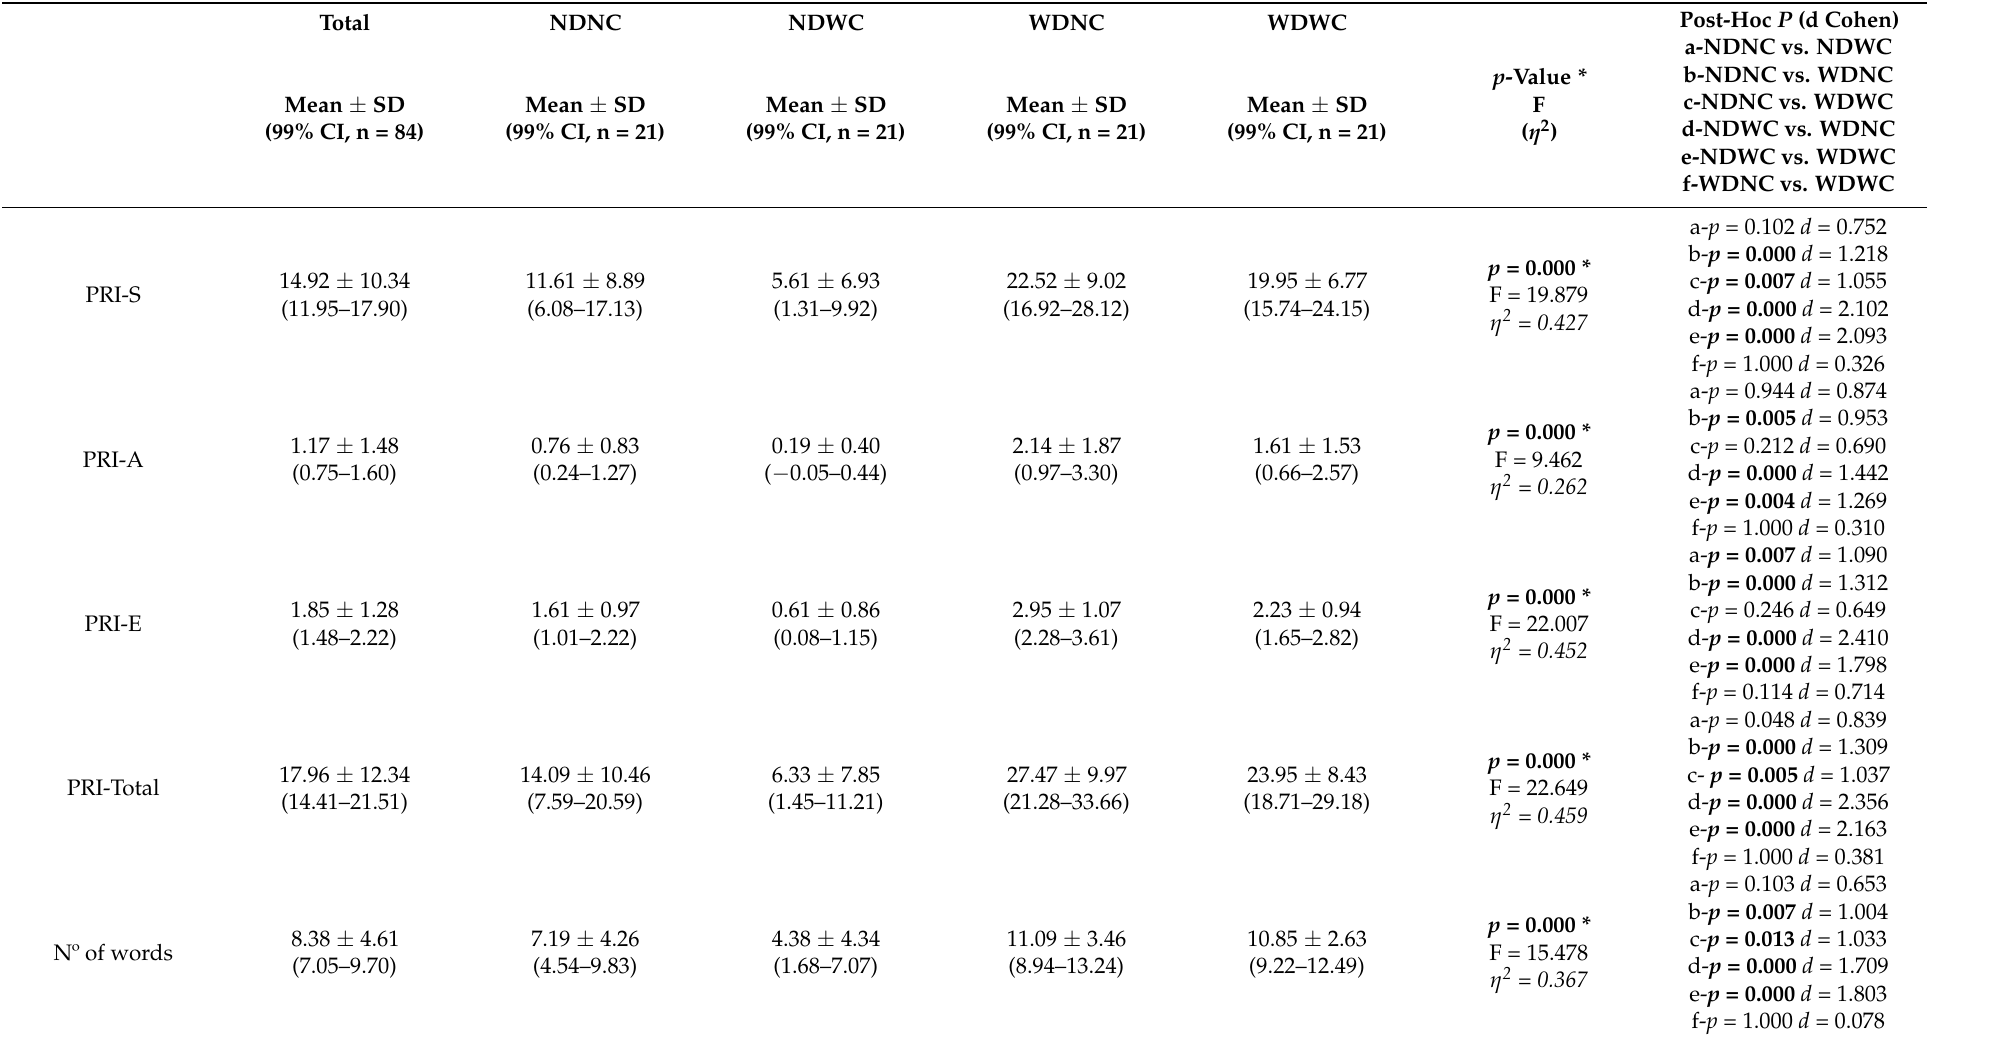
Table 4. The McGill Pain